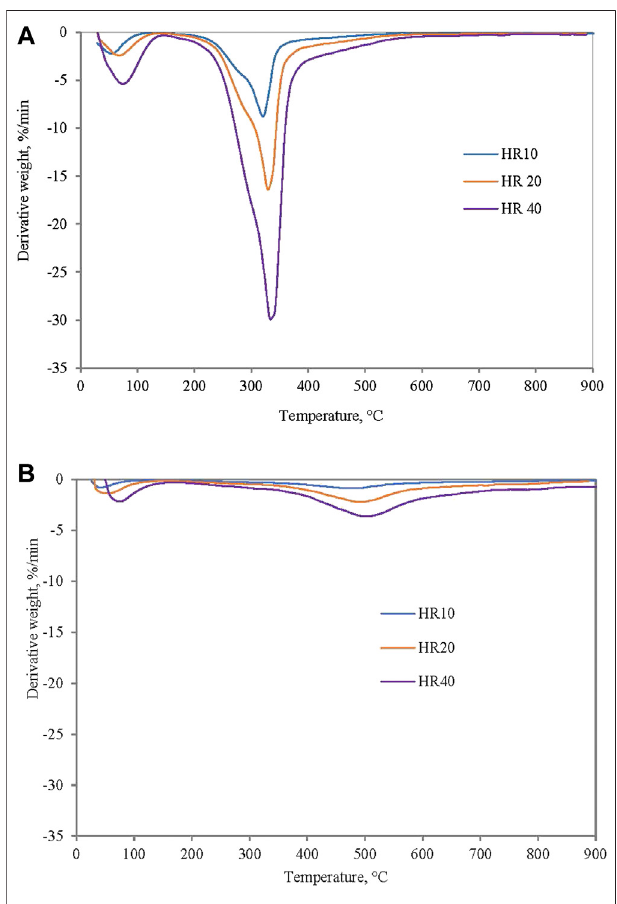
FIGURE3 | DTG pro fi les of (A) EFB and (B) Silantek coal (SC) at heating rates of 10, 20, and 40 ° C/min under pyrolysis